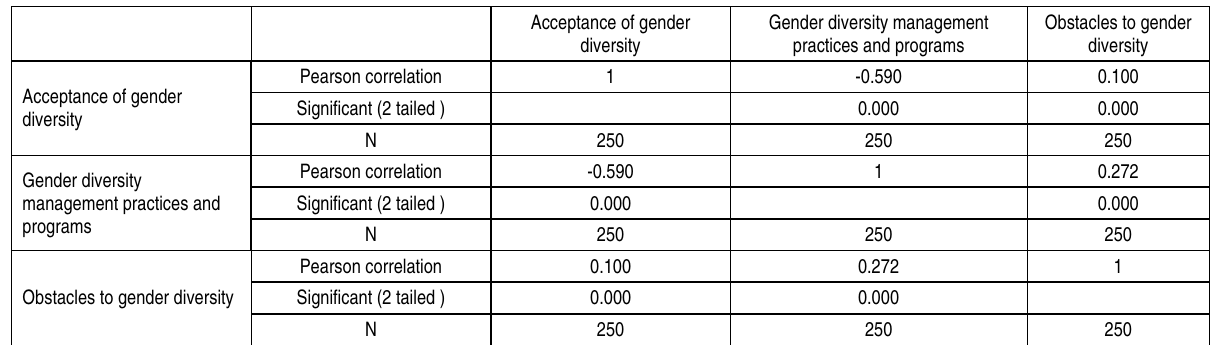
Table 10. Correlation coefficient for variables